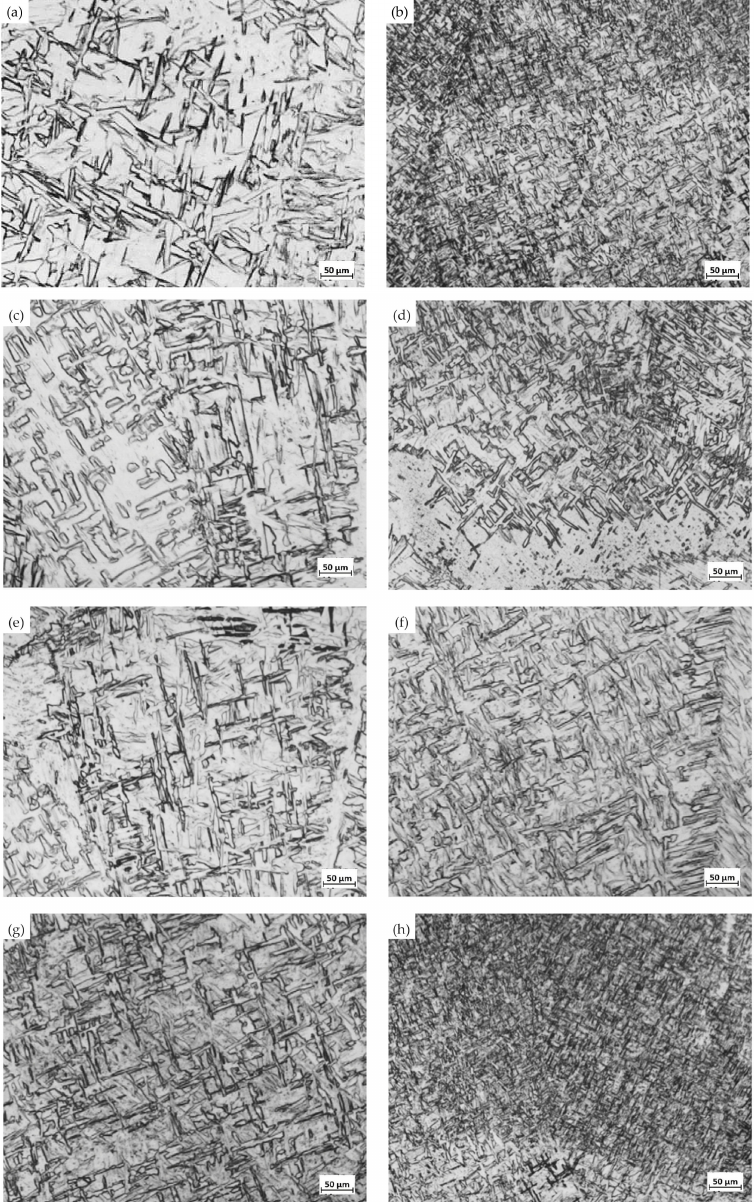
Figure 6. Microstructure comparison of the weld zone (WZ) before and after sandblasting annealed at different temperatures. ( a ) 500 ◦ C; ( b ) 500 ◦ C+ sand blasting; ( c ) 550 ◦ C; ( d ) 550 ◦ C + sand blasting; ( e ) 600 ◦ C; ( f ) 600 ◦ C+ sand blasting; ( g ) 650 ◦ C; ( h ) 650 ◦ C + sand